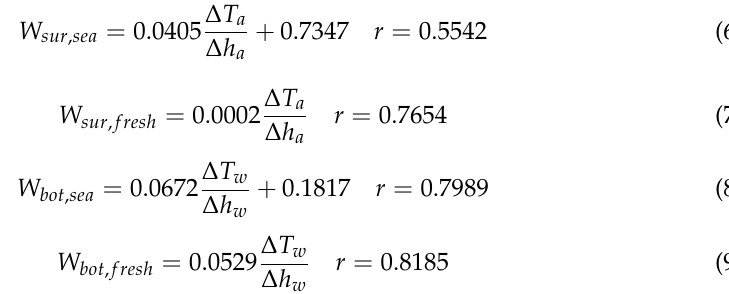
Figure 8. The statistical relationship between the bottom melting rate and vertical water tempera- ture gradient. ( a ) Sea ice ( b ) fresh-water ice.